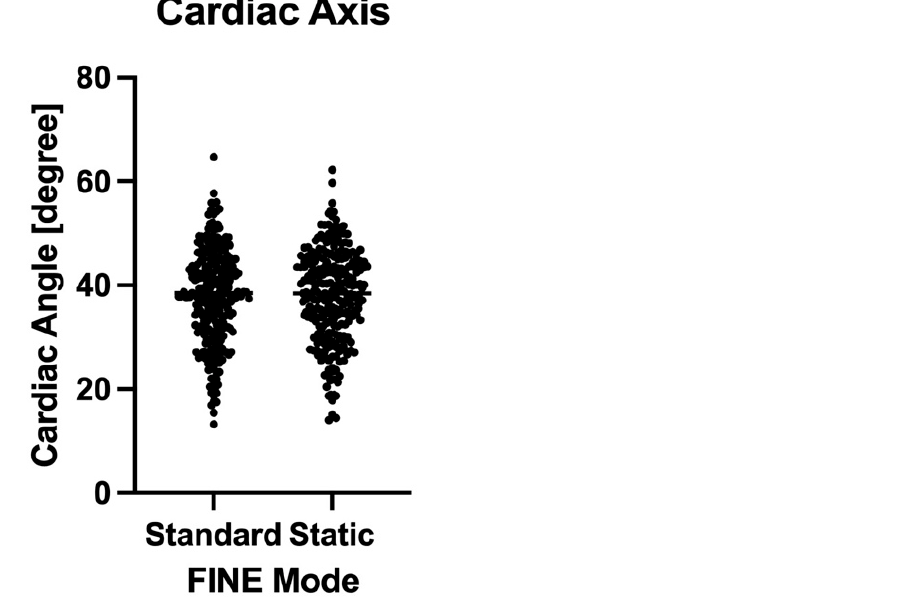
Figure 2. Distribution of the cardiac axis angles measured by FINE standard and static mode.